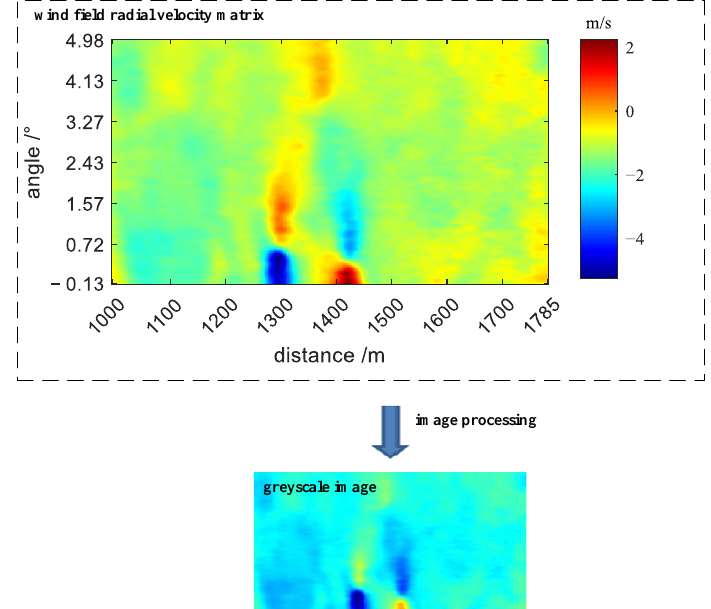
Figure 4. Lidar image conversion.